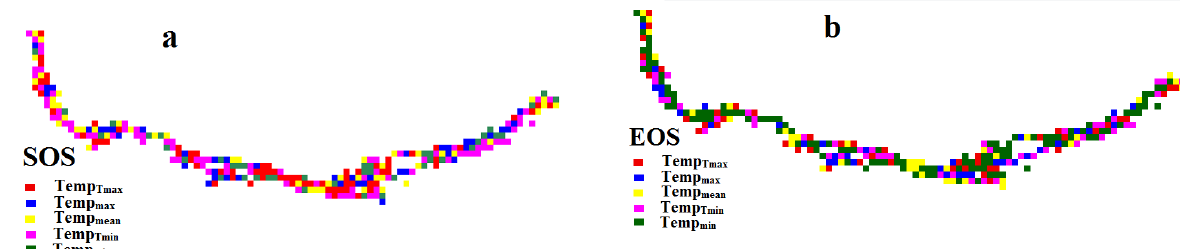
Figure 6: Spatial distribution of best regression between SOS (a) and EOS (b) with temperature